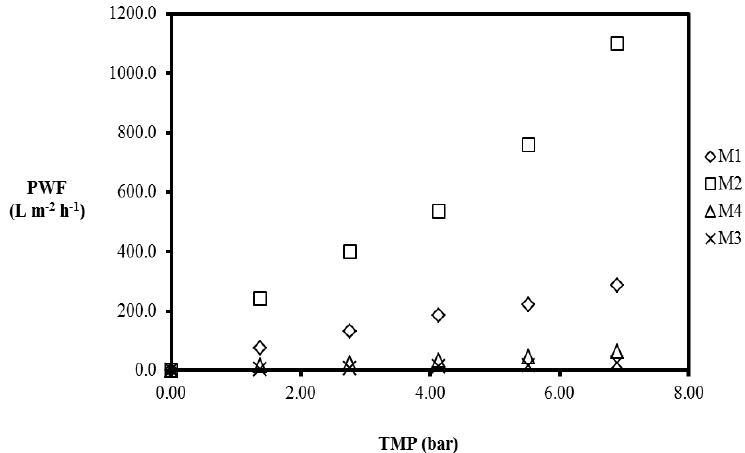
Figure 7. Pure water flux (PWF) of M1, M2, M3 and M4. Experimental conditions: